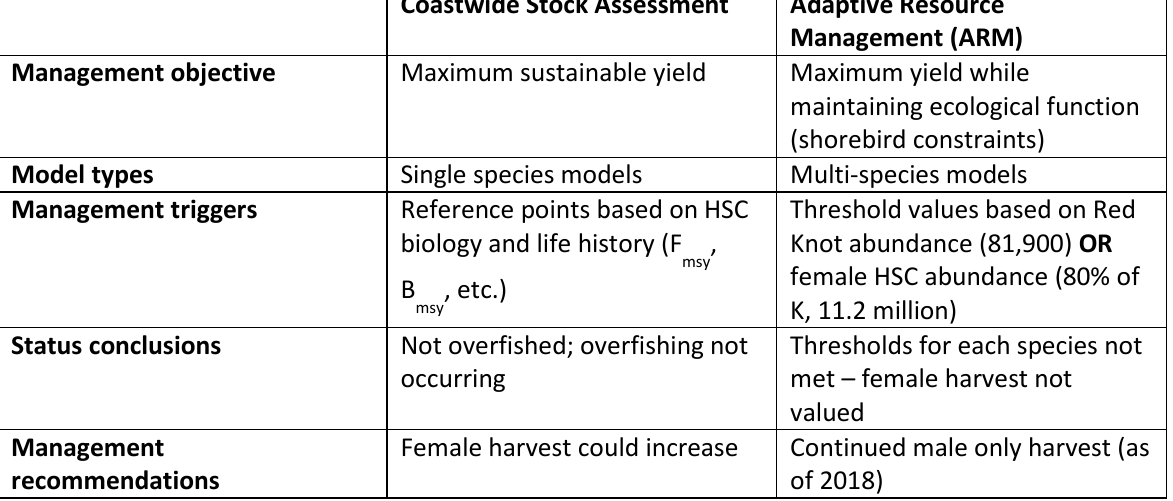
Table 55. Comparison of the current stock assessment and the adaptive resource management (ARM) model for horseshoe crabs in the Delaware Bay